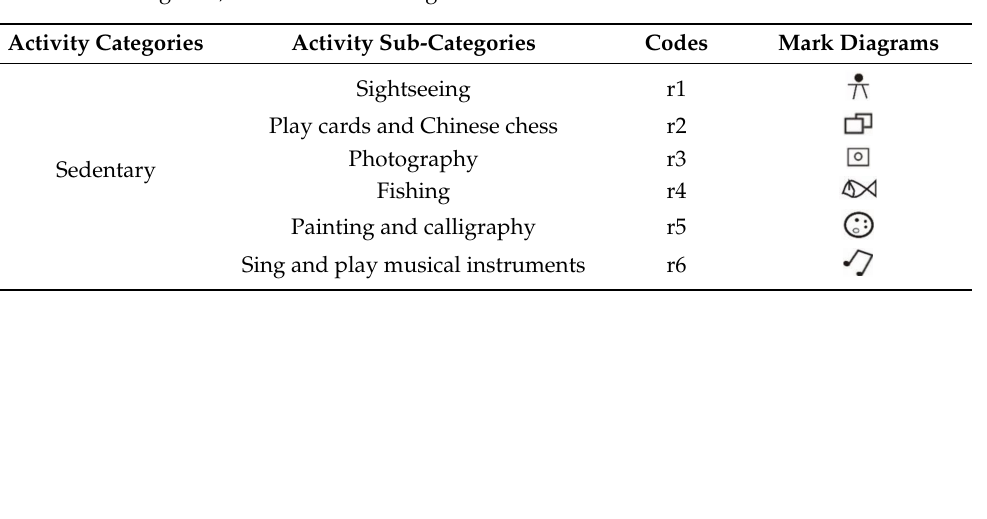
Table 3. The categories, codes and mark diagrams of recreational